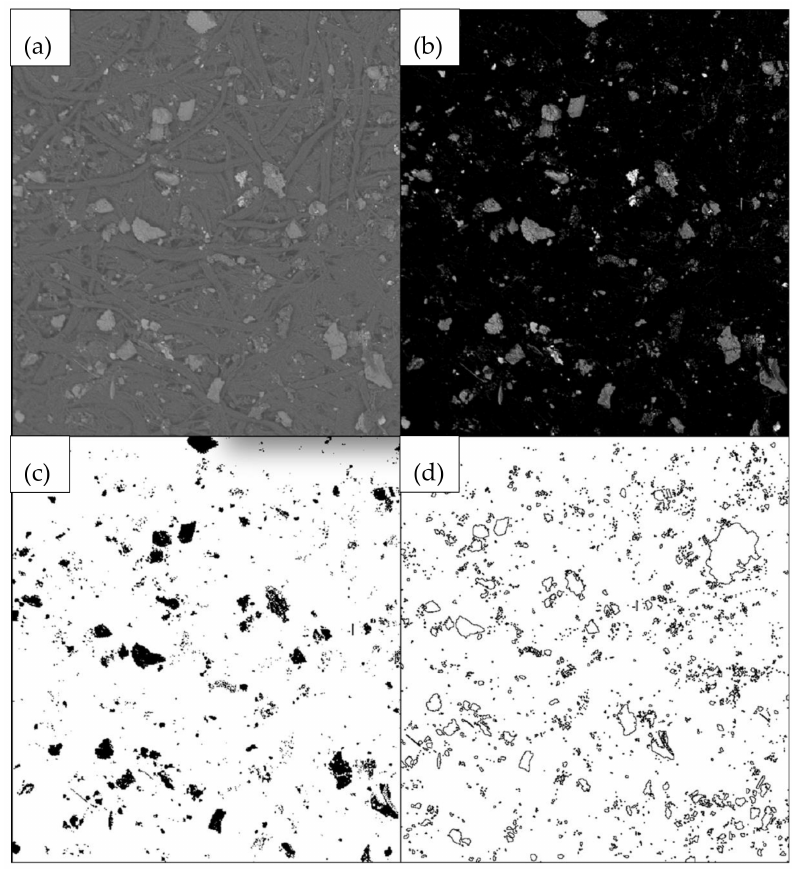
Figure 3. Images displaying steps taken in particle size analysis from the original image ( a ) to an increased contrast for clearly identifying particles ( b ), creation of a binary image with separation of particles from the background ( c ), and an image of the counted particle outlines ( d